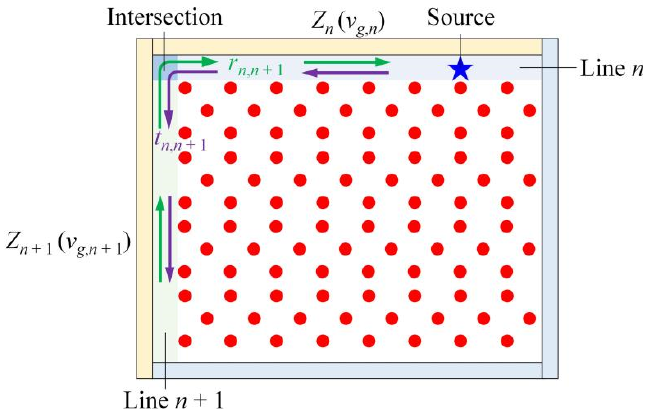
Figure 3. Schematic diagram of matching transmission line network. The upper and left boundaries were set as perfect electric conductors (colored in yellow) to form the transmission lines (Line n and Line n + 1). The lower and right boundaries were set as the scattering boundary conditions (colored in blue) to avoid the reflection of EM waves. The blue star is the line source, the green and purple arrows at the intersection represent the reflected waves ( r n , n +1 ) and transmitted waves ( t n , n +1 ), respectively. The impedances (group velocities) of the upper and left transmission lines are Z n ( v g,n ) and Z n +1 ( v g,n +1 ), respectively.